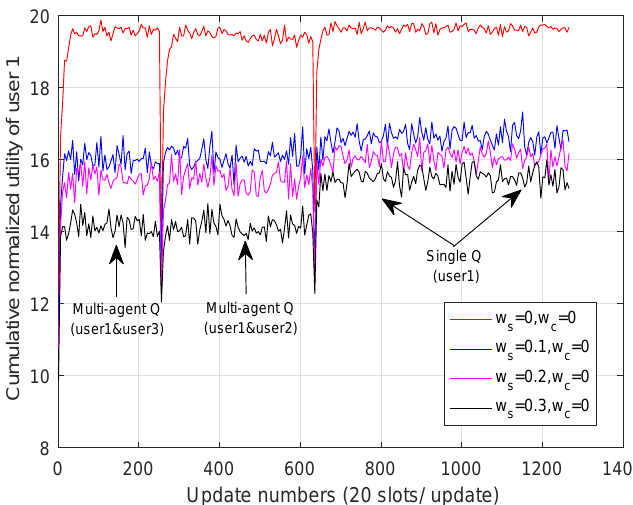
Figure 11. The cumulative normalized utility of User 1 with different channel switching costs.